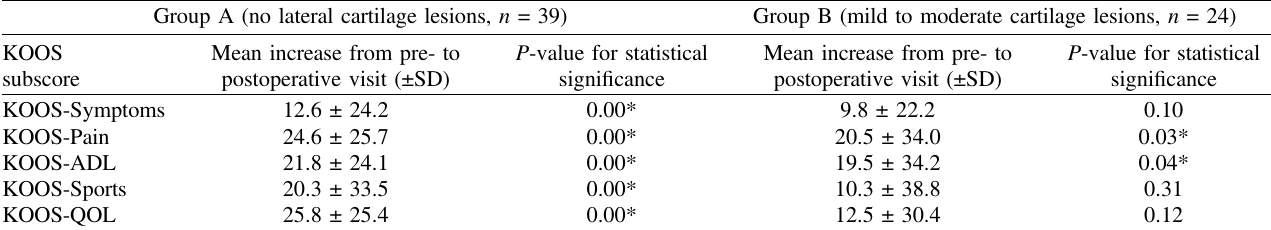
Signi fi cant differences are highlighted by an asterisk. SD: Standard